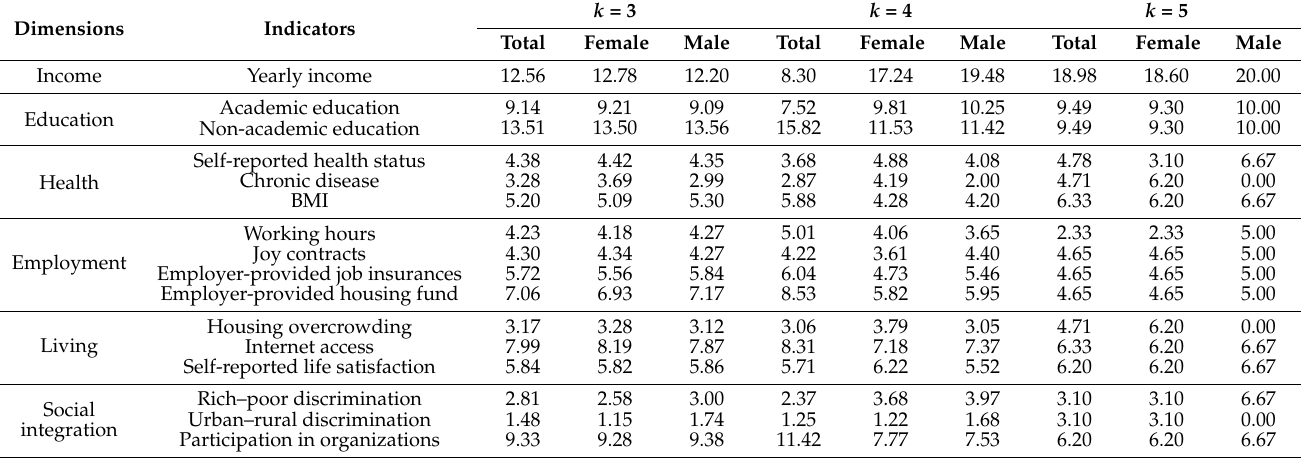
Figure 1. Migrant workers’ relative poverty incidence index (%) in multiple dimensions. Table 3. Percentage contribution of dimensions/indicators to migrant workers’ relative poverty incidence index and gender